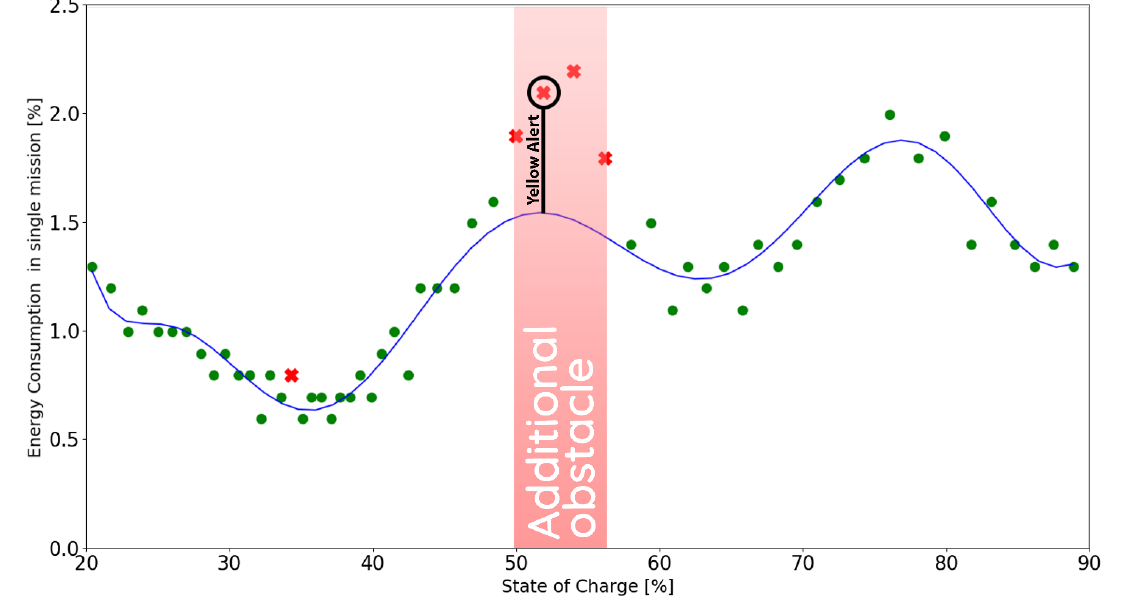
Figure 14. Energy consumption in experimental scenario 3, where ● represent the correctly executed missions and the ❌ represent the incorrectly executed ones.